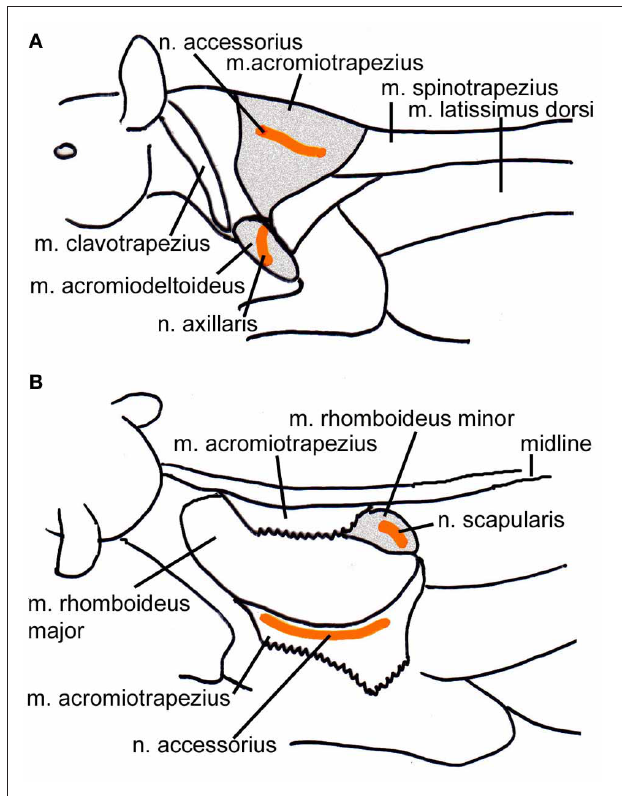
FIGURE 1 | Schematic drawings of the location of the injected muscles also indicating the position of the innervating nerves. (A) Lateral view from the left depicting the m. acromiotrapezius and the m. acromiodeltoideus. (B) Dorsolateral view of the left side of the animal; the m. acromiotrapezius has been deflected to reveal the underlying m. rhomboideusminor. Relevant muscles are shaded, the course of the nerves is indicated in orange.